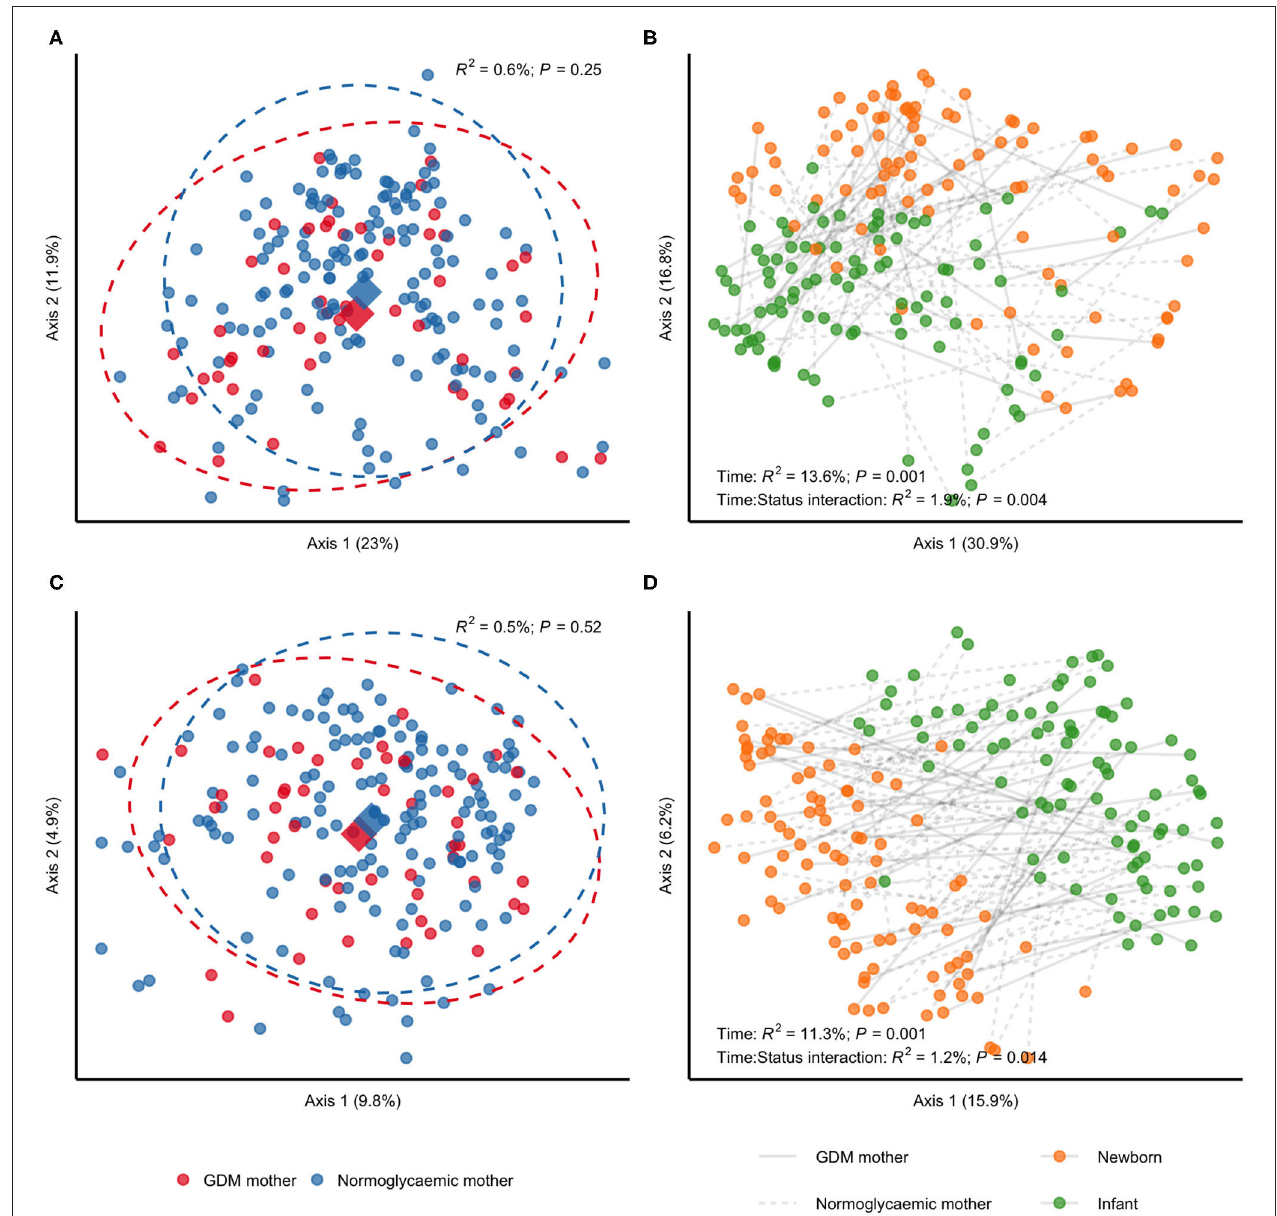
FIGURE 3 | Community structure and membership of gut microbiota in children born to mothers with GDM compared with children born to mothers without GDM. All samples analyses were rarefied to an equal sequencing depth of 10,000 reads prior to principal coordinate (PCo) analysis based on weighted (A,B) and unweighted (C,D) UniFrac distances. (A,C) Samples from newborns of mothers with ( n = 34) or without ( n = 72) gestational diabetes. Points are individual samples and diamonds represent the average ordination scores and ellipses the 95% confidence intervals of a multivariate normal distribution of either group. R 2 and P are from permutational multivariate analysis of variance (PERMANOVA) as implemented in the adonis function of the vegan R package. (B,D) Change in community structure from birth (1 week of life) to infancy (at an average of 9 months of life). Only samples from children examined at both time points are included ( n = 32 and n = 64 for children of mothers with and without GDM, respectively). R 2 and P are from PERMANOVA testing for a difference in community structure between newborn samples and samples collected during infancy (PERMANOVA model specified as (Distances ∼ Time, strata = Subject), where Time is a two-level factor) and for a differential change in community structure or membership in children of mothers with GDM compared with children of mothers without GDM (PERMANOVA model specified as (Distances ∼ Time:Status, strata = Subject), where Time:Status is a two-way interaction between GDM status and time with contrasts specified as GDM:Infant–GDM:Newborn–NGR:Infant + NGR:Newborn). for difference in feeding during infancy had a minor attenuating effect on the differential change in community structure, but no effect on the differential change in community